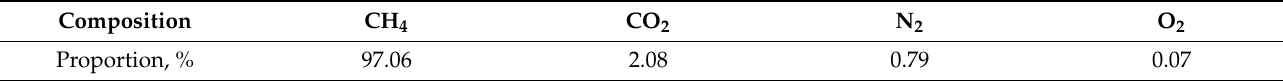
Table 3. Chemical composition of